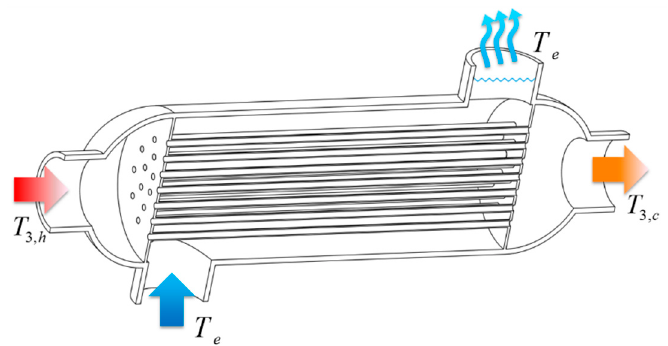
Energies 2020 , 13 , x FOR PEER REVIEW